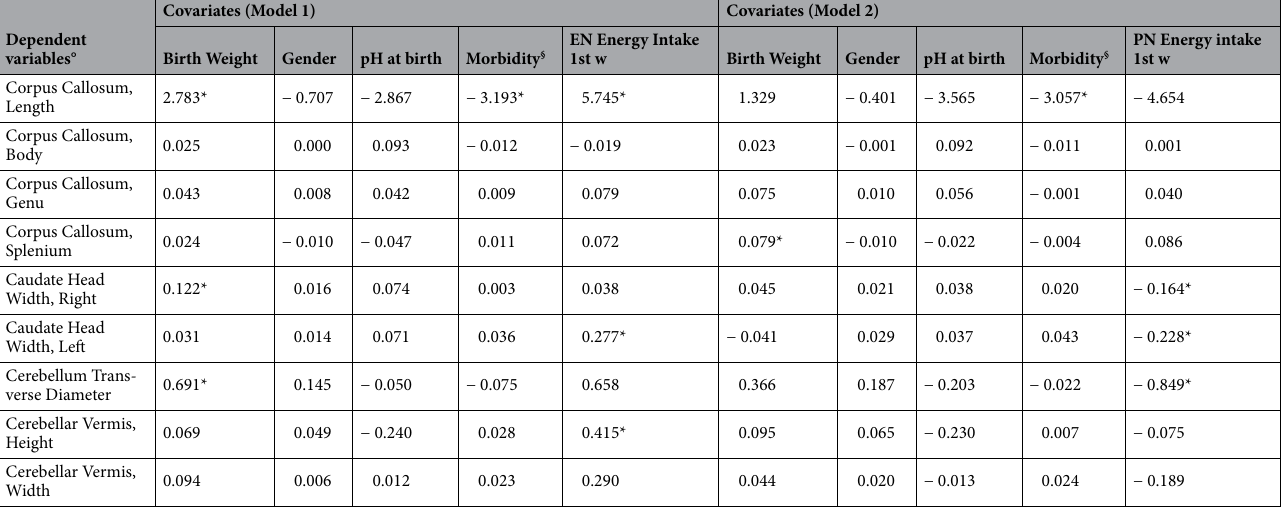
Table 3. Multivariate analysis of covariate influencing cerebral growth measures of the first 28 days of life in preterm newborns. Growth measurement: (T1 − T0)/T0. EN enteral nutrition, PN parenteral nutrition, 1st w first week of life, § NEC necrotizing enterocolitis and/or Sepsis proven by positive cultures and/or BPD bronchopulmonary dysplasia and/or ROP retinopathy of prematurity. * p <